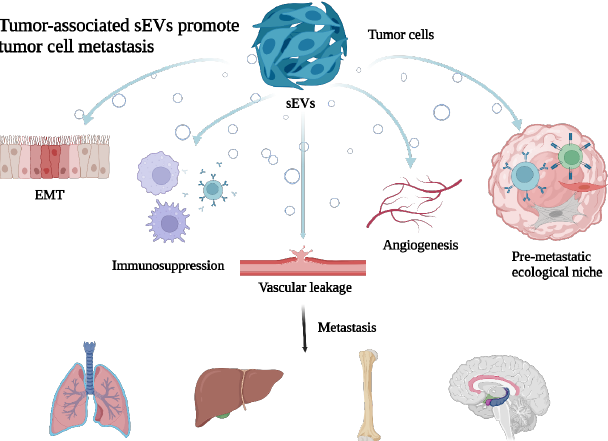
Figure 1. Tumor-associated sEVs promote tumor cell metastasis. Tumor-derived sEVs through promoting cellular epithelial – mesenchymal transformation (EMT), reshaping the tumor microenvironment (TME), immunosuppression, increase vascular leakage and angiogenesis to promote cancer metastasis. 2. Small Extracellular Vesicles Affect Colorectal Cancer Metastasis by Remodeling the Tumor Microenvironment CRC cells undergo a series of complex and highly regulated processes as they metas- tasize to surrounding and distant organs and tissues. The TME plays a crucial role in the process of tumor metastasis. The TME refers to the surrounding microenvironment where tumor cells exist, and includes surrounding blood vessels, immune cells, fibroblasts, in- flammatory cells, various signaling molecules, and the extracellular matrix (ECM) [27]. The fundamental role of TME is to interact dynamically with malignant tumor cells [28]. TME promotes tumor cell proliferation and metastasis by recruiting immunosuppressive cells, remodeling the ECM, and promoting angiogenesis [5]. sEVs are currently thought to regulate the TME by playing a key signaling mediator role (Table 1). Tumor cells secrete sEVs that act on various cells in the TME, including fibroblasts, endothelial cells, and local immune cells, to induce a pro-tumor phenotype in different cells. Then, the tumor-affected cells release sEVs, which in turn increase the motility and invasive potential of tumor cells, promote angiogenesis and the formation of pre-metastatic ecological sites, and facilitate drug resistance. Through these and other mechanisms, sEVs promote the tumor metasta- sis cascade [29].